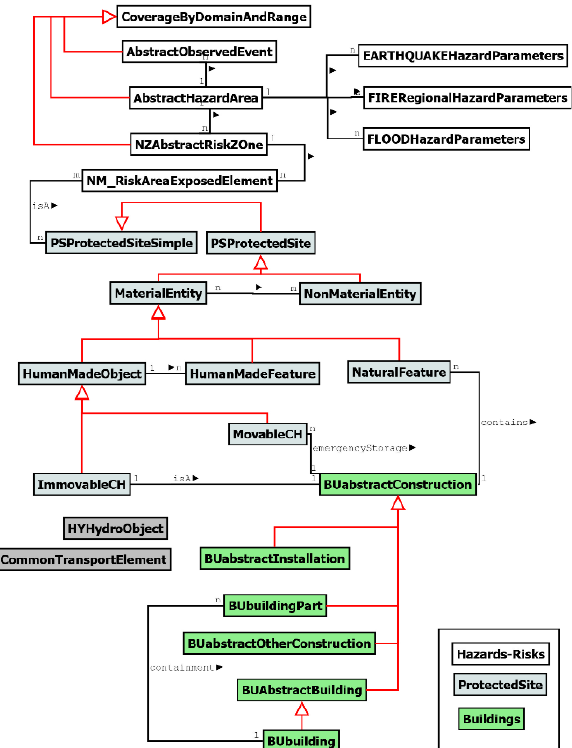
Figure 1. Simplified schema of the EID conceptual model (the red arrows symbolise the relations “inherit from”, the black arrows the general relations, specified in each